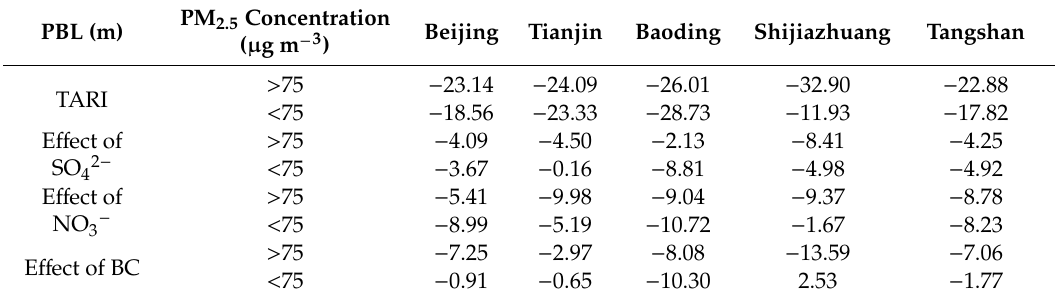
Figure 10. Simulated results of ARI effects under different particulate matter components on the PBL. Table 6. The effects of the ARI on the PBL under different PM 2.5 pollution levels.